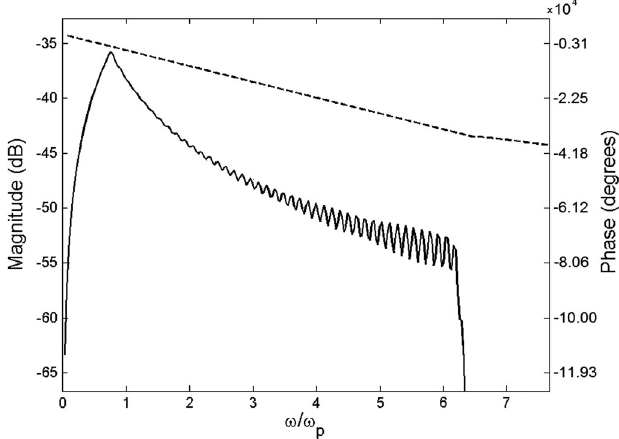
FIG. 2. Amplitude (solid line) and phase response (dashed line) of an example